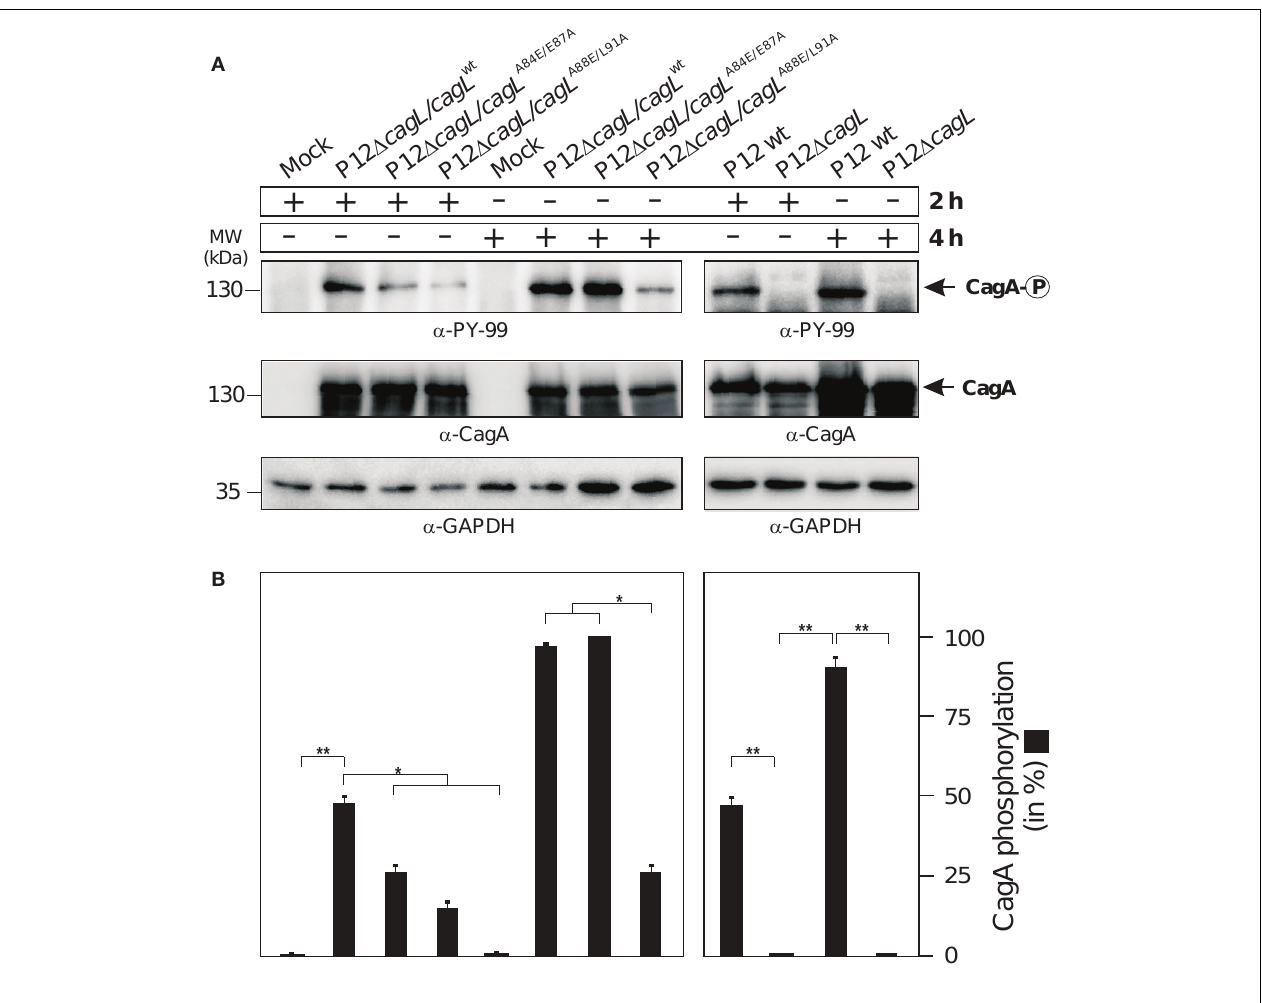
antibodies.The α -GAPDH blot served as loading control in each sample. (B) Quantification of CagA phosphorylation. Densitometric measurement of individual band intensities of the α -CagA and α -phospho-tyrosine (PY-99) blots in (A) was performed with the Lumi-Imager F1 (Roche). Quantification revealed the relative amount of phospho-CagA per sample in %. Similar inhibitory activities of all mutants were seen when MOI = 50 was used (not